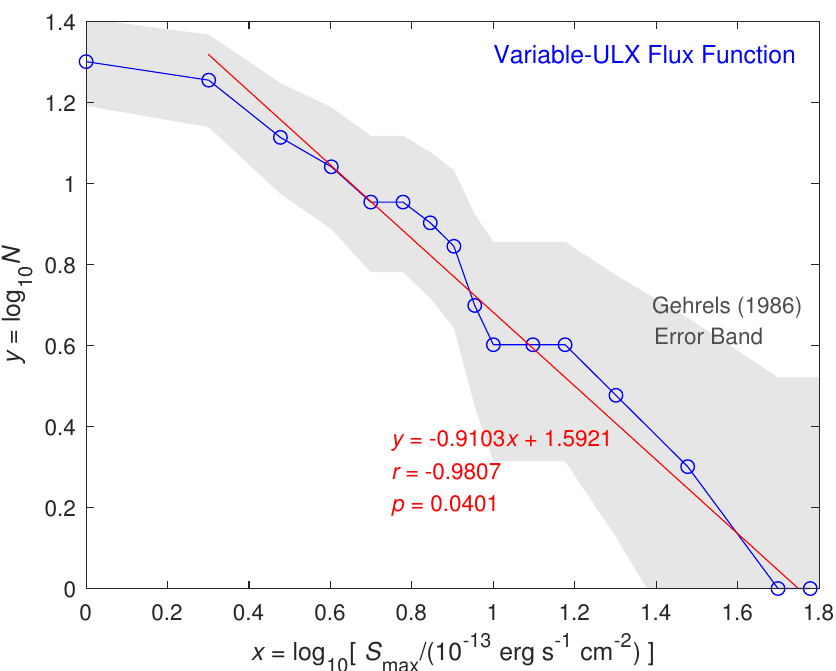
Figure 6. Cumulative number N of ULX sources above a flux level S max versus S max on logarithmic scales (blue points). The data indicate a strong linear correlation (correlation coefficient r = − 0.9807) with a steep slope of − 0.9103 and a p -value statistic of p = 0.0401, better than the 2 σ confidence level (red line). The grey area respresents the 1 σ error bars to the data points according to the prescription of [44]. The errors in the best-fit line are listed in Table